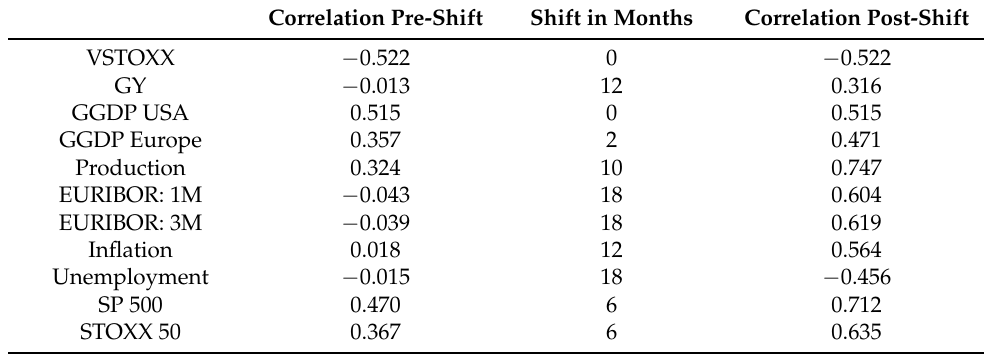
Table 3. Correlations between the ARR and explanatory variables before and after optimal time